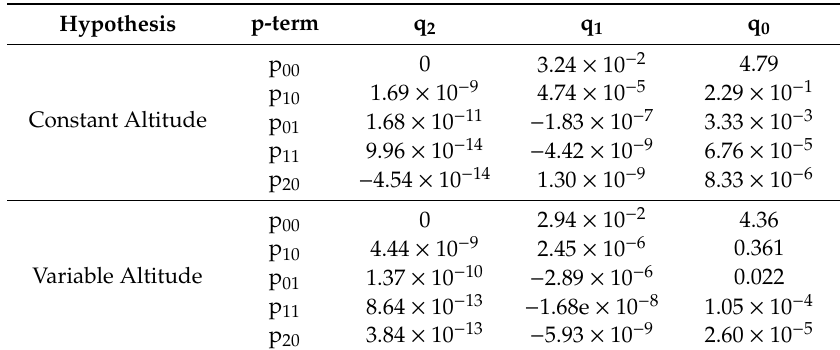
Table 2. Response surface coe ffi cients as a function of OEW (Operating Empty Weight): p q OEW 2 + q OEW + q 2 1 0